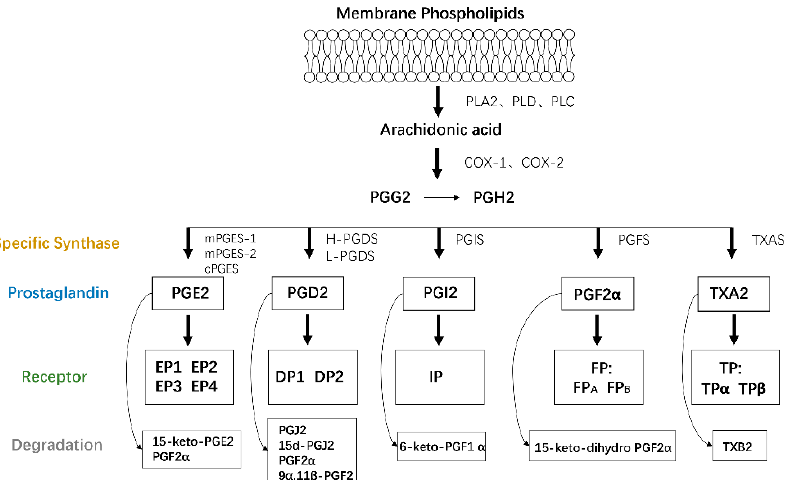
Figure 1. PG production. Membrane phospholipids are metabolized into AA by the PLA2, PLD, or